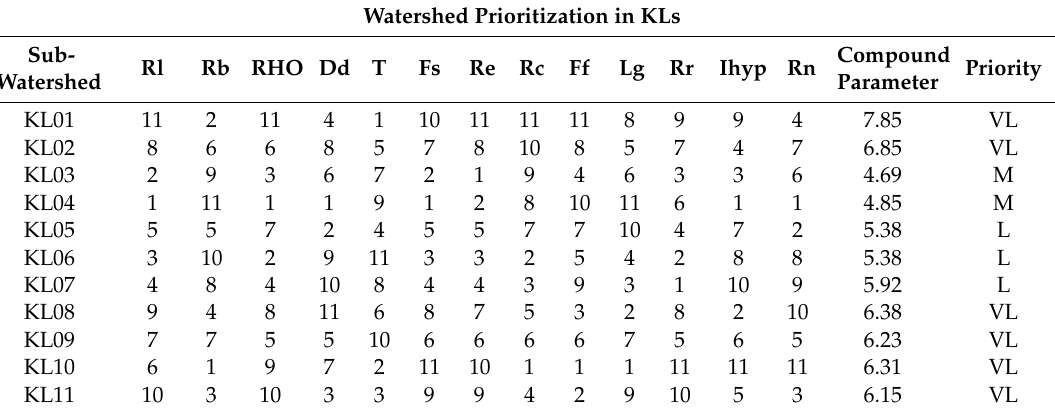
Table 4. Watershed prioritization in each sub-watershed in KLs. Watershed Prioritization in